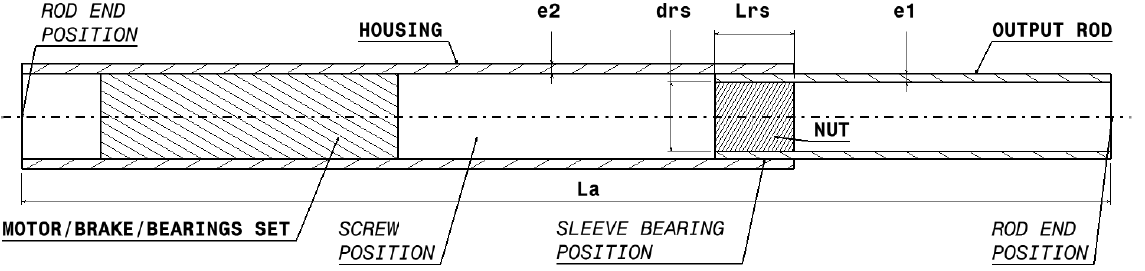
Figure 16. Actuator simplified geometry for modal